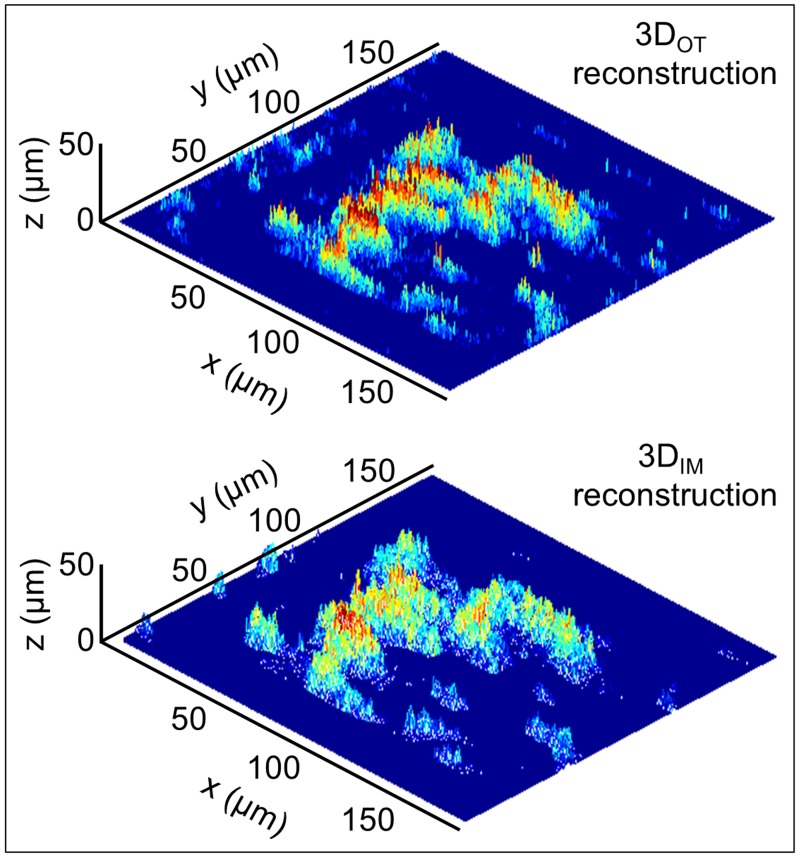
Three-dimensional rendering.Example of a 3D representation of volume distribution obtained with Optical Thresholding (3DOT reconstruction) and with Impedance Measurements (3DIM reconstruction) at t = 300 s.